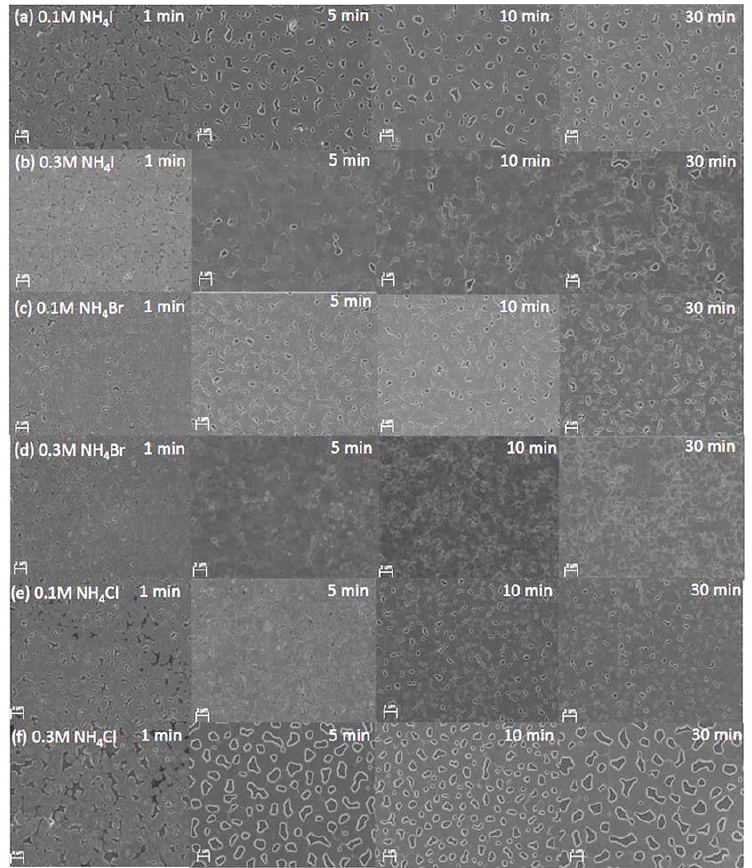
Figure 4. FE-SEM images of CH 3 NH 3 PbI 3-x Cl x layers coated on PEDOT:PSS layers. The CH 3 NH 3 PbI 3-x Cl x solutions used for spin-coating contained ( a ) 0.1 M NH 4 I, ( b ) 0.3 M NH 4 I, ( c ) 0.1 M NH 4 Br, ( d ) 0.3 M NH 4 Br, ( e ) 0.1 M NH 4 Cl, and ( f ) 0.3 M NH 4 Cl, respectively. The samples were annealed at 100 ◦ C for different times (1, 5, 10, and 30 min). The scale bar is 2 µ